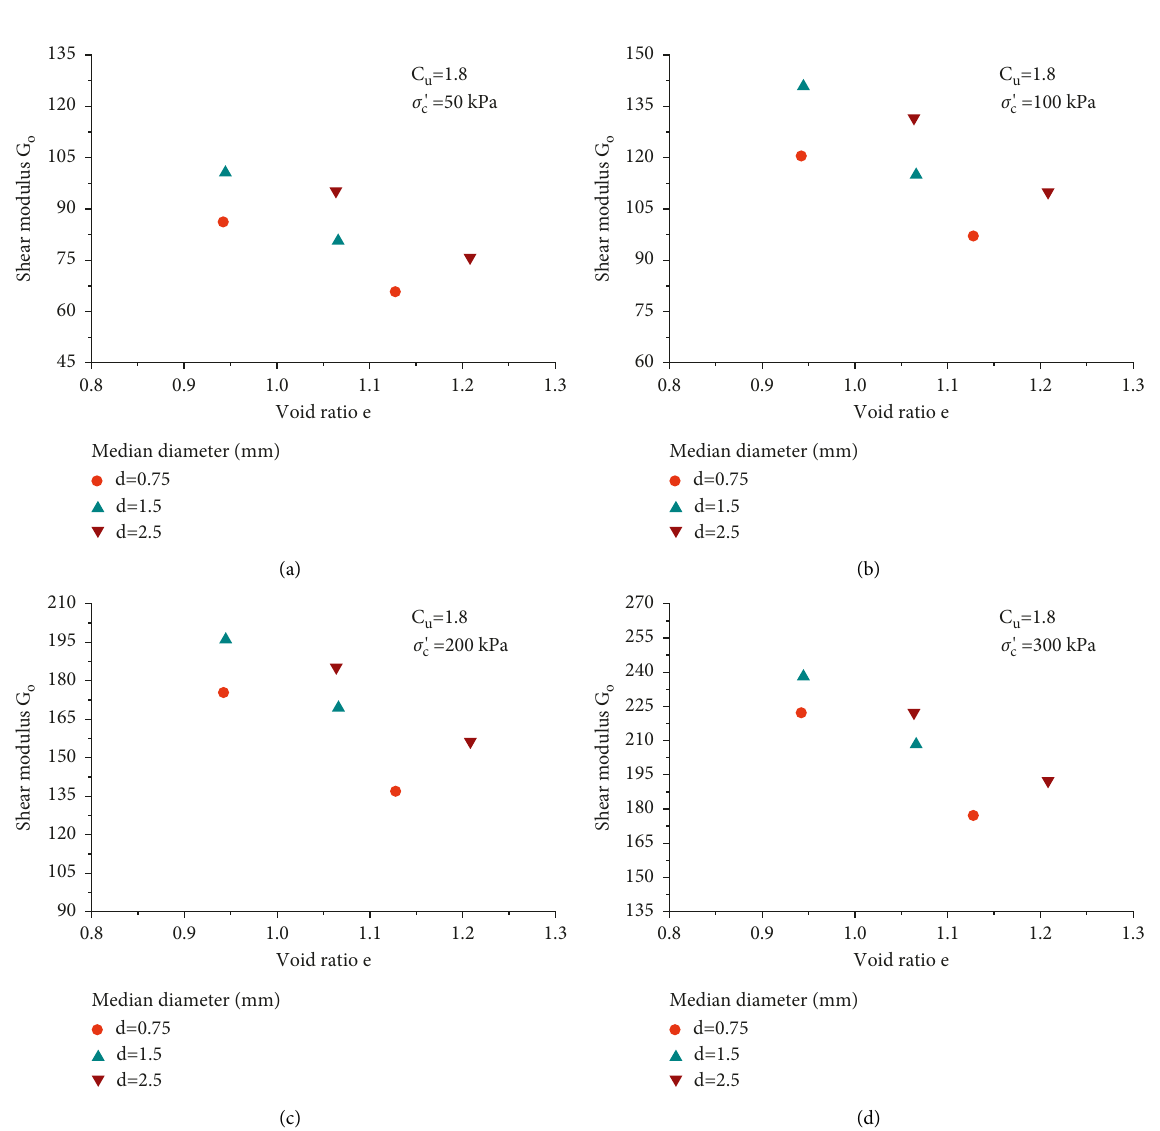
Figure 10: Maximum shear modulus and void ratio for calcareous sand with Cu � 1.8. (a) 50kPa, (b) 100kPa, (c) 200kPa, and (d)